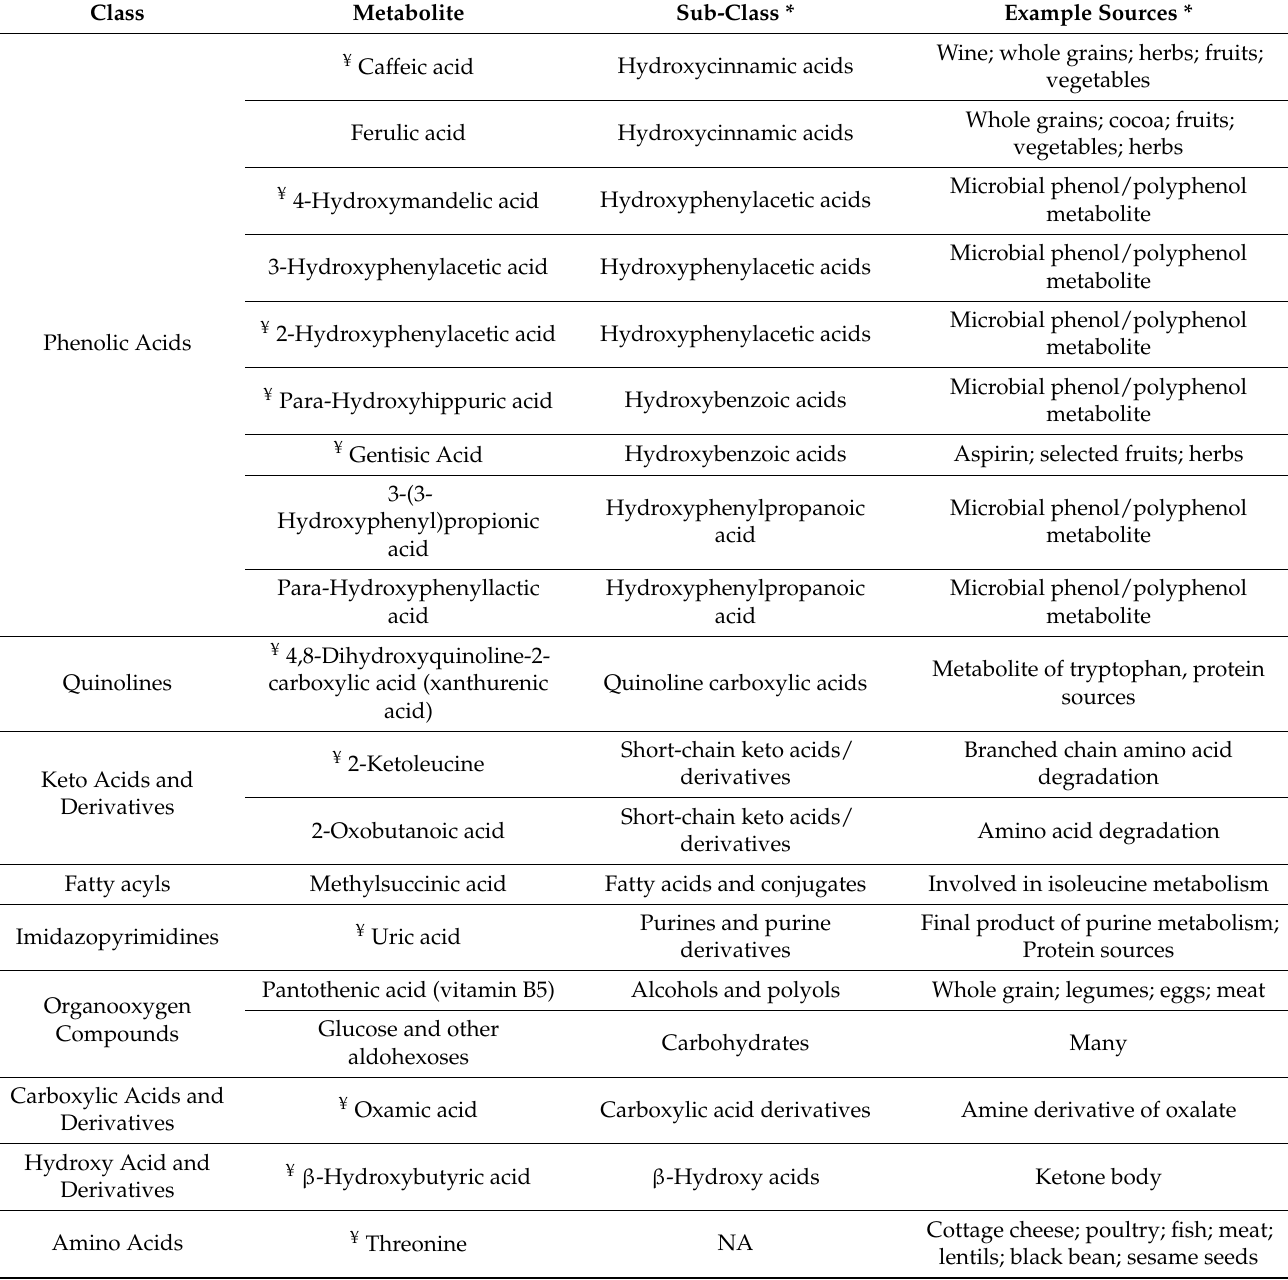
Table 2. Annotation of identified urine metabolites as candidates modified by